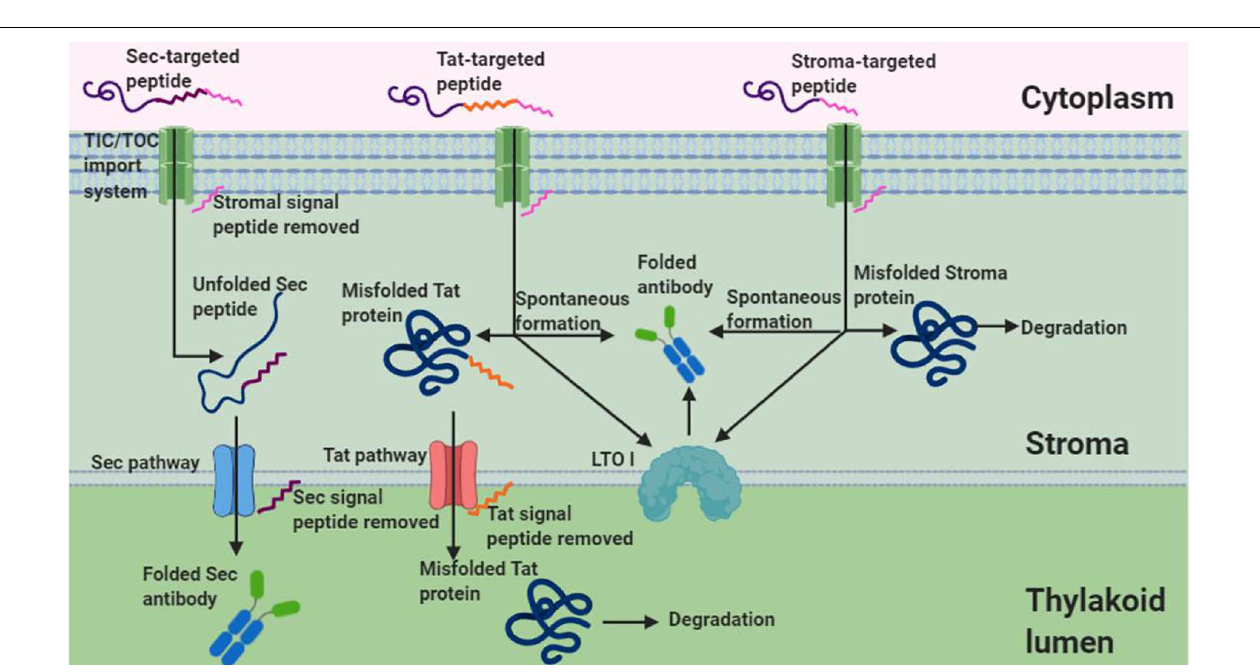
FIGURE 6 | V H H-Fc targeted with either Sec, Tat or stromal transit peptides can neutralize adherence of O157:H7 to HEp-2 cells. Shown are confocal images of O157:H7 (white) that has been incubated with Hep-2 cells (red) in the presence of either V H H-Fc targeted to Sec, Tat, and stromal compartments or Fc as a negative control targeted to the same compartments. Size bar = 20 µ m.